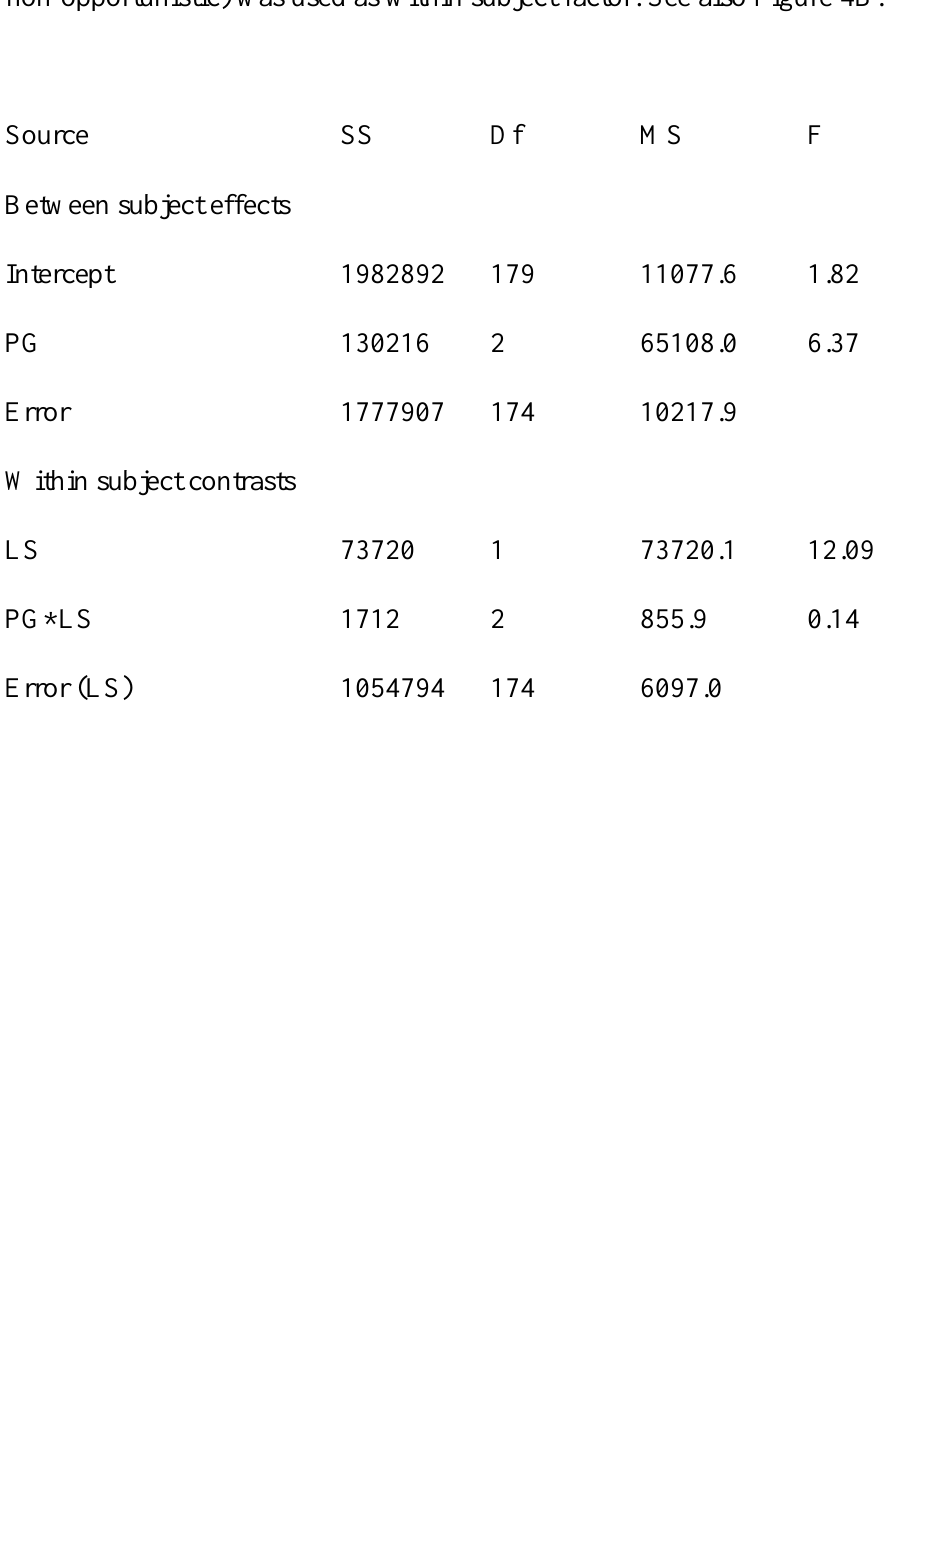
Table S6: Repeated measures-2-way-ANOVA of the ranked perception of pleasantness of odor from six decaying macrophytes. Phylogenetic groups (= PG, green plants, brown algae or red algae) were used as between subject factor and life strategy (= LS, opportunistic or non-opportunistic) was used as within subject factor. See also Figure